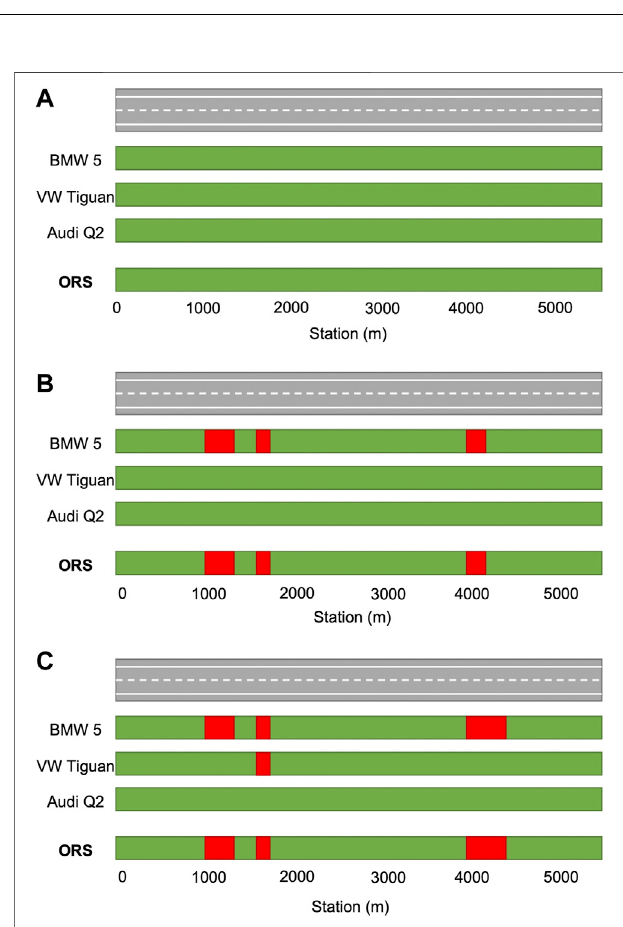
FIGURE 5 | Determination of Operational Road Sections (in green) for different steady speeds: (A) 70 km/h; (B) 80 km/h; (C) 90 km/h.